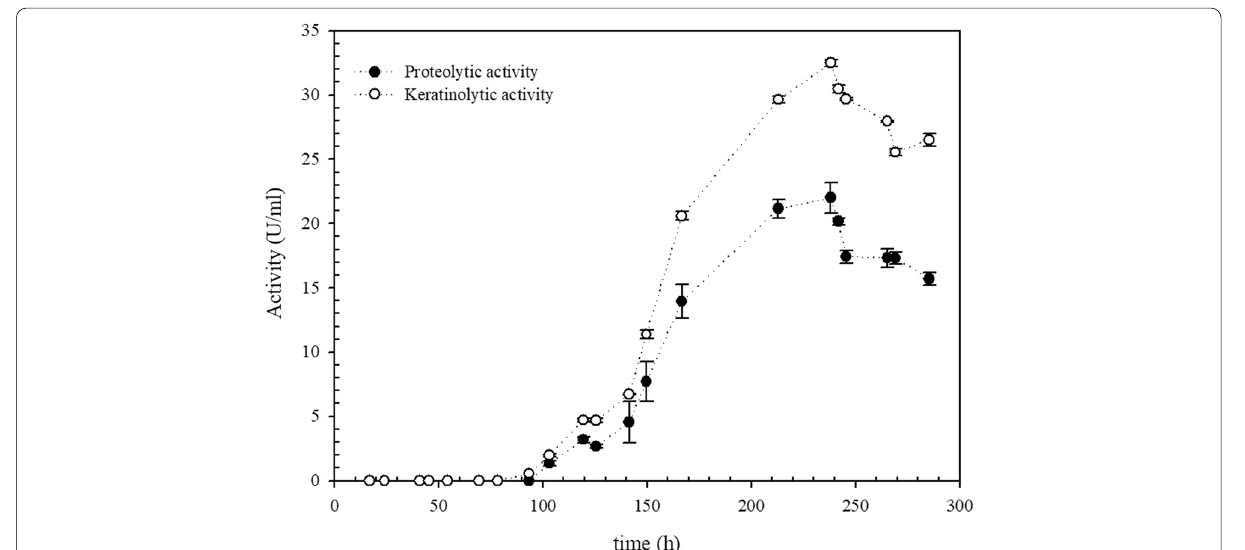
Fig. 3 Time course of production of protease and keratinase expressed by Pedobacter sp.